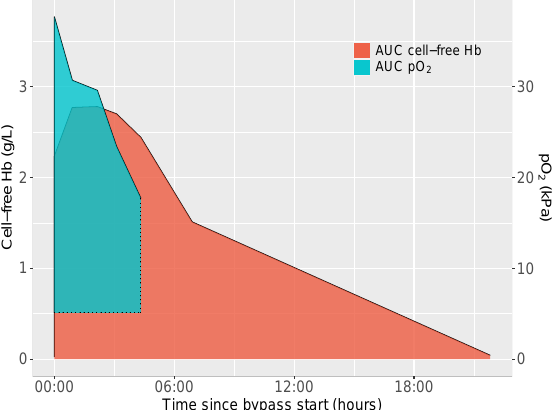
Figure 1. Representative image of area under curve (AUC) determinations for cell-free hemoglobin exposure (red) and oxygen exposure (turquoise) in one patient. Cell-free hemoglobin exposure was calculated as area under curve from start of bypass ( x = 0) and terminated at postoperative day 1 or at PICU admission according to chosen analysis. Oxygen exposure was calculated as area under curve from start of bypass ( x = 0) until separation of bypass. Baseline for calculations of oxygen exposure was set to preoperative oxygen tension. Cell-free hemoglobin concentrations are displayed on the left y -axis, whereas oxygen tensions are displayed on the right y -axis. Hb = hemoglobin, AUC = area under